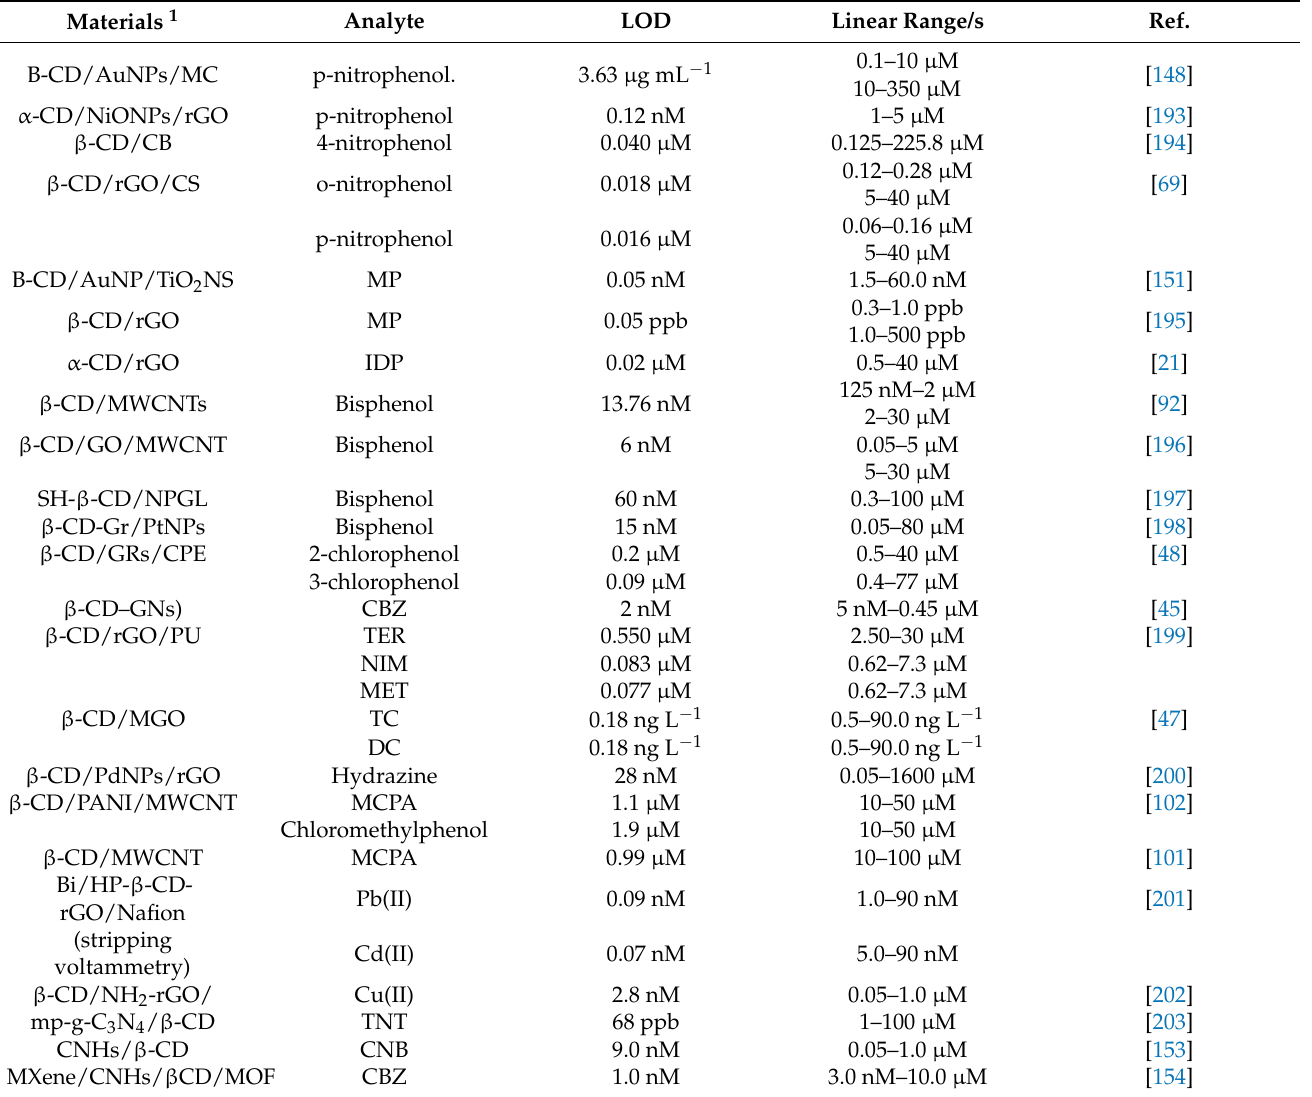
Table 2. Summary of some of the CD-based sensors used in the determination of environmental contaminants. Materials